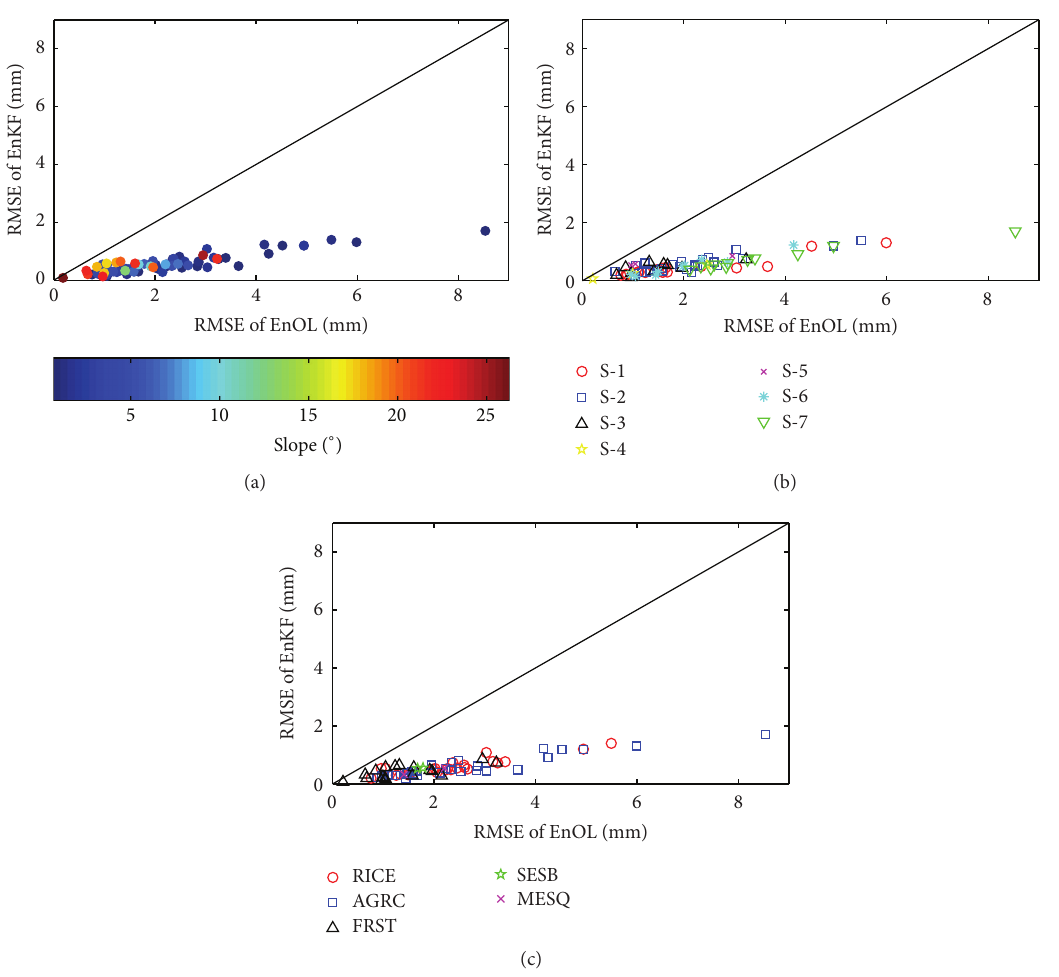
) on 82 HRUs by EnKF and EnOL with varying (a) stor